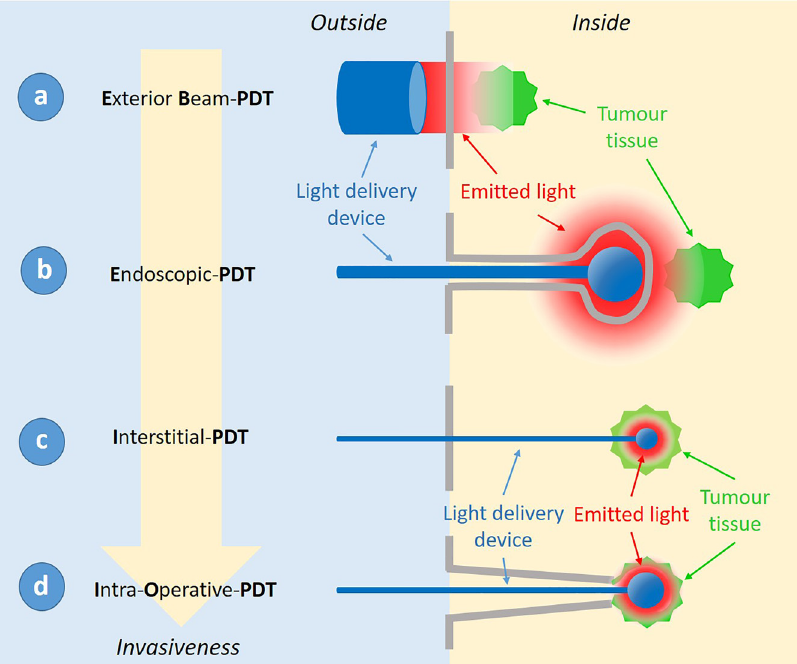
Figure 3: Main light delivery systems in clinical PDT for cancerous tumor